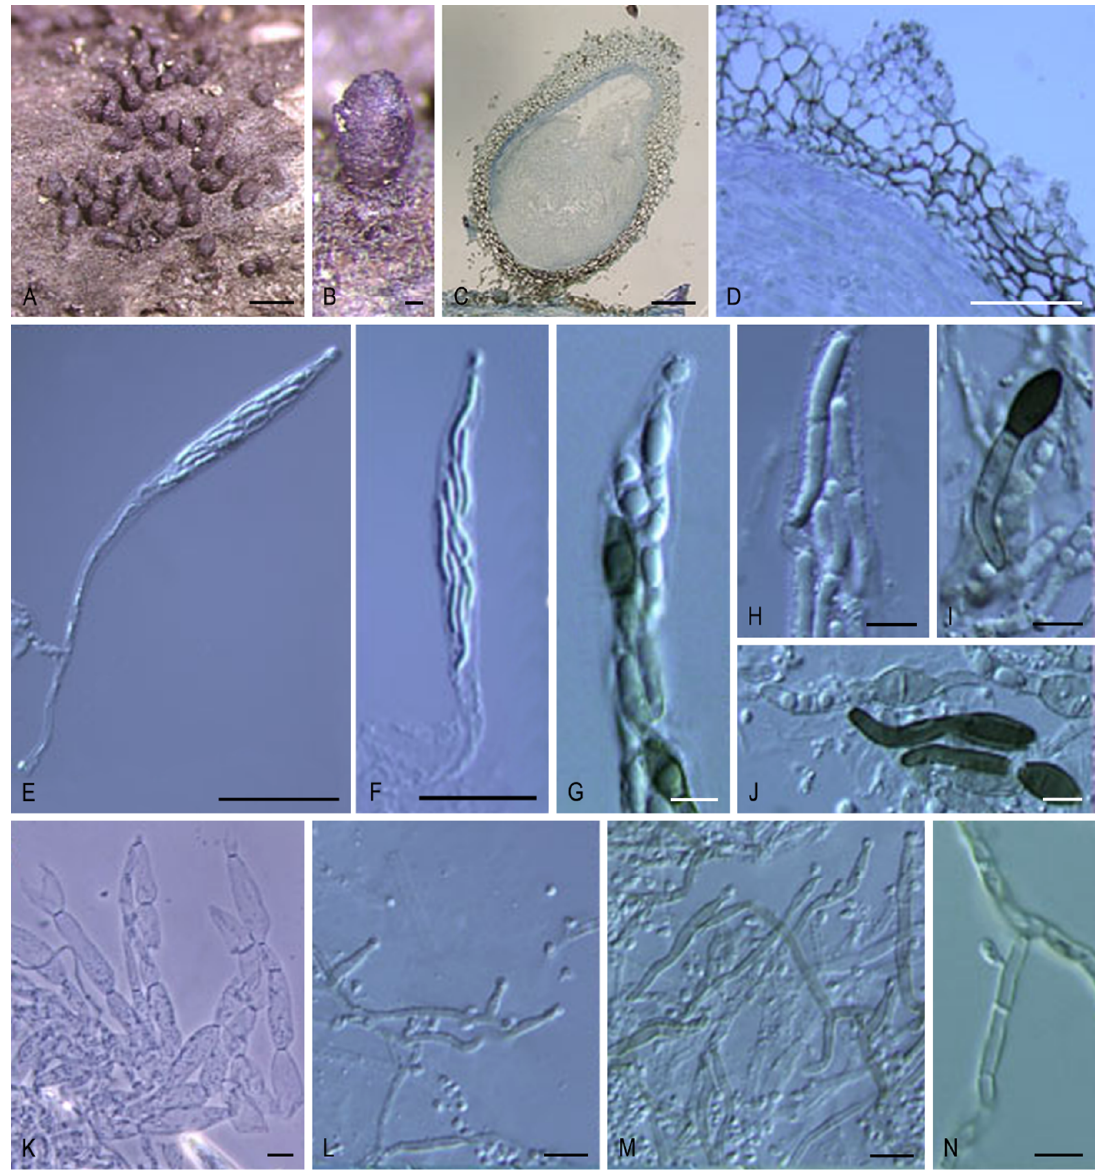
Figure 13. Pseudoschizothecium atropurpureum SMH 3073. ( A – C ) Ascomata. ( D ) Ascomatal wall. ( E , F ) Asci. ( G , H ) Ascus apex. ( I , J ) Ascospores. ( K ) Paraphyses. ( L – N) Conidiogenous cells and conidia. Bars: ( A ) = 1 mm; ( B , C ) = 100 µm; ( D – F ) = 50 µm; ( G – N ) = 10 µm. All pictures adapted from [48]. Schizothecium Corda, Icon. Fungorum 2: 29. 1838. emend. Y. Marin & Stchigel. MycoBank MB4908. Type species: Schizothecium fimicola Corda.